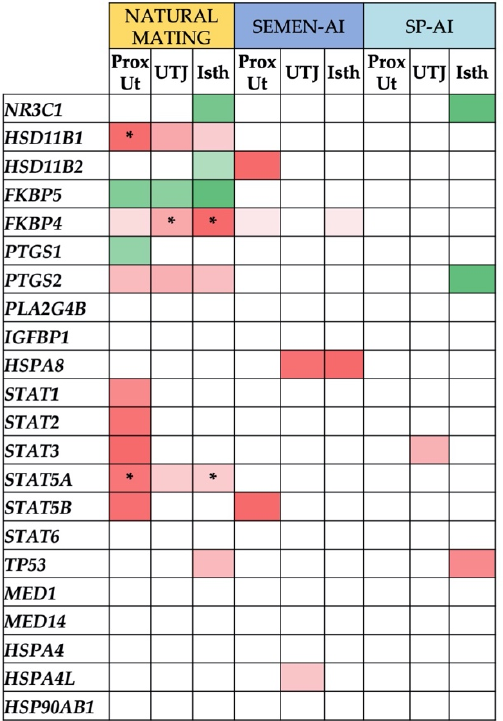
Figure 2. Differentially-expressed genes (DEGs) in proximal uterus (ProxUt), utero-tubal junction (UTJ), and isthmus (Isth) tissues, ordered by treatments (natural mating, semen-artificial insemination (AI), or sperm-free (SP)-AI). Upregulated genes ( p < 0.05) are marked in green, while downregulated genes ( p < 0.05) are shown in red. Color grading is displayed, ranging from 1 (upregulated) to − 1 (downregulated), separately for every treatment. False discovery rates ( q < 0.05) are noted with an asterisk.